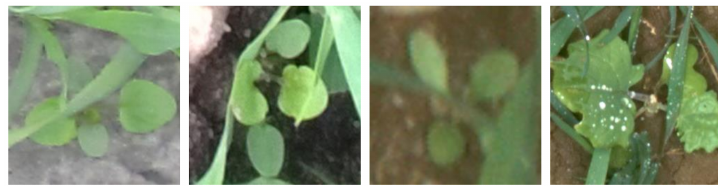
Figure 3. Samples of difficult images, where not all leaves are fully visible due to overlapping